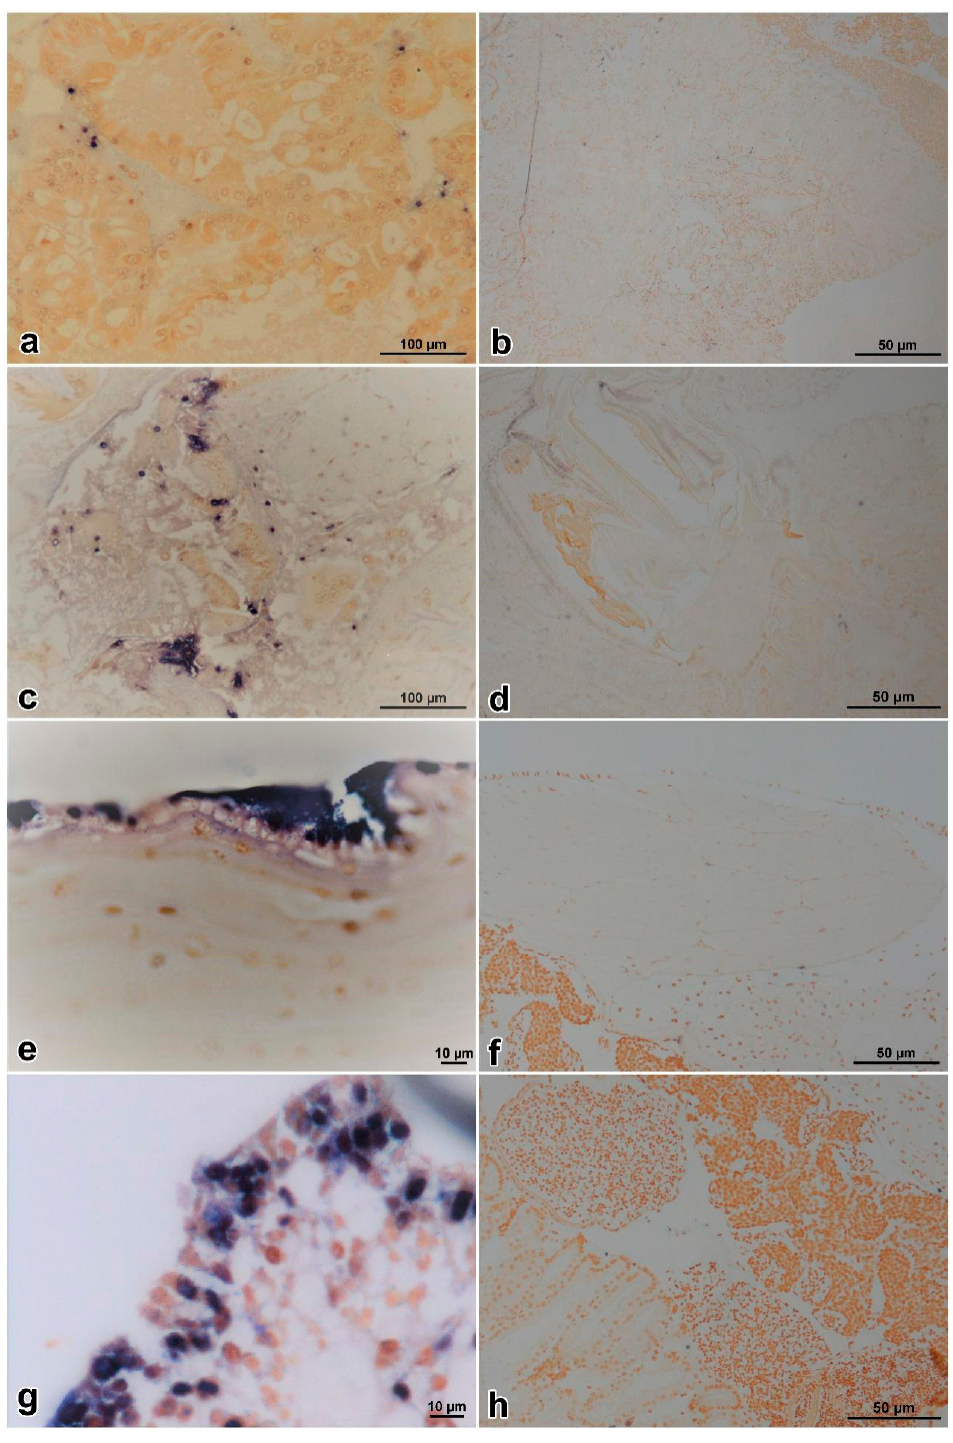
Figure 6. In situ DIG-labeling-loop-mediated DNA amplification (ISDL) micrographs of DIV1-infected and control Exopalaemon carinicauda . Hepatopancreas, stomach, cuticular epithelium, and hematopoietic tissue from a challenged prawn of the PO group, respectively ( a , c , e , and g ); hepatopancreas, stomach, cuticular epithelium, and hematopoietic tissue from a healthy prawn of the CPO group, respectively ( b , d , f , and h ). In pictures a, c, e, and g, blue-violet signals were observed in hepatopancreatic sinus, stomach epithelium, cuticular epithelium, and hematopoietic tissues of prawns, respectively. In pictures b, d, f, and h, no hybridization signal was seen in the same tissues of DIV1-negative E. carinicauda , except some non-specific signals on gastric sieve of